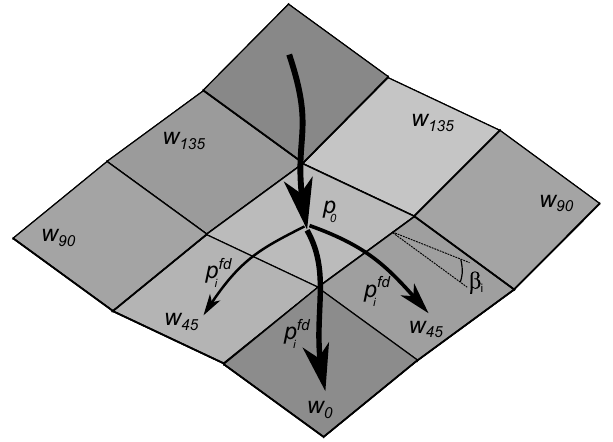
Fig. 4. Illustration of the spreading of susceptibility value to the neighbouring cells.